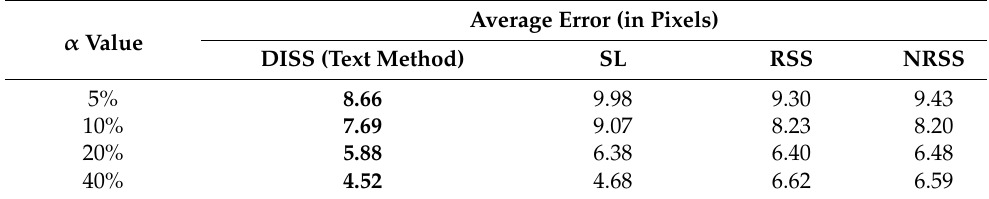
Table 3. The mean value of errors under different values of α